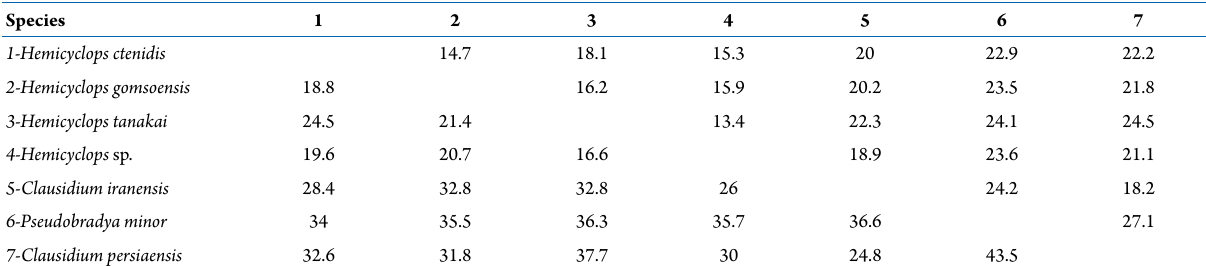
Table 2. The percentage of mean genetic divergence in the CO1 gene between the species of the genera Hemicyclops , Clausidium , and Pseudobradya . Numbers in upper right (Bold) are P-distances and in lower left are Kimura’s two-parameter (K2P) distances. Species